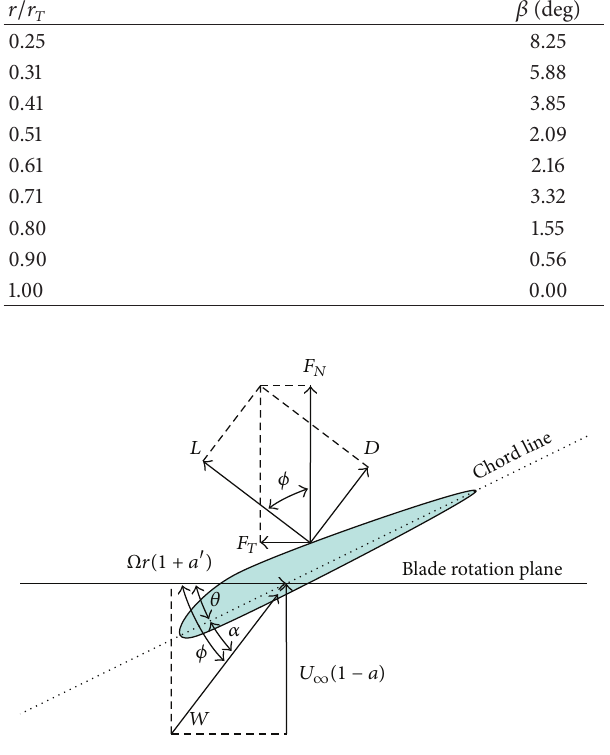
Figure 1: Velocity and force triangles for an airfoil section of a rotating wind turbine